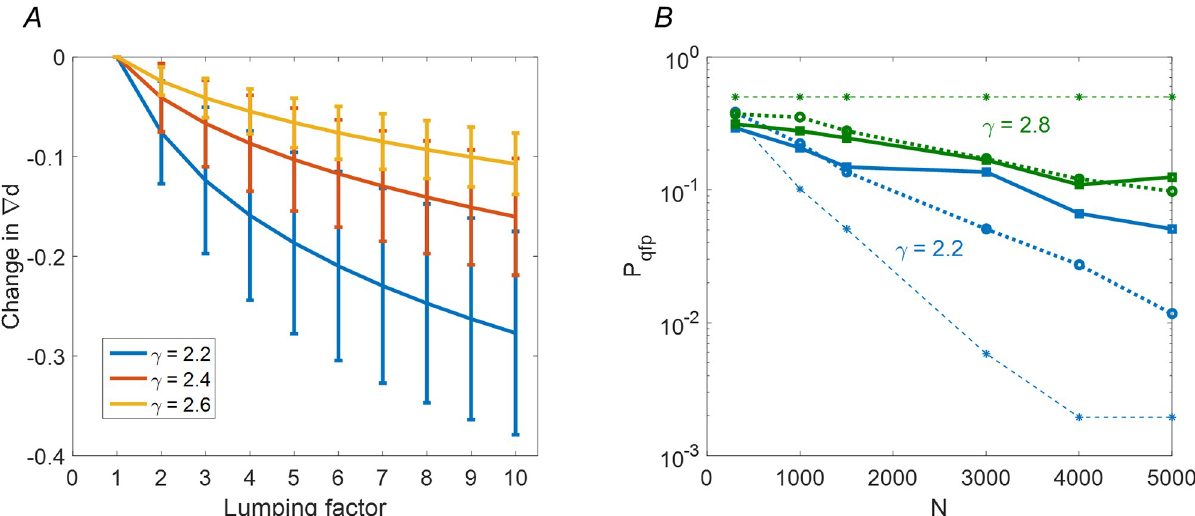
Fig 7. Limits of the approximation. (A) Sensitivity of lumped hub approximation to the number of leading nodes being lumped is shown for 1000 realisations of scale-free topology with fixed parameters k min = 1, N = 1500, and for three values of γ = 2.2, 2.4, 2.6. For each realization, the r d at m = 1 is taken as reference, from which the subsequent decrease in r d is measured. (B) Fig 6D is replicated for γ = 2.2, 2.8. In the large γ case, the lumped hub model holds, while mean field theory becomes invalid due to extreme sparseness. For low γ it is the lumped hub model per se that becomes inaccurate, due to sensitivity to choice of m